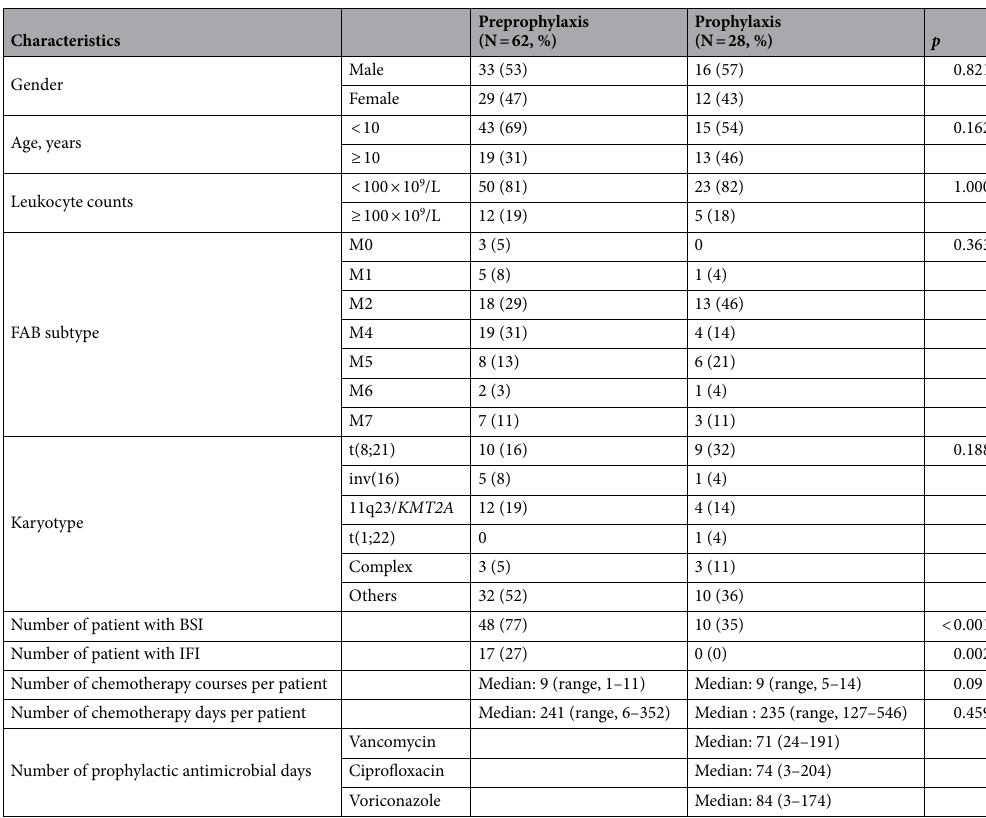
Table 1. Presenting characteristics. BSI, bloodstream bacterial infection; FAB, French-American-British; IFI, invasive fungal